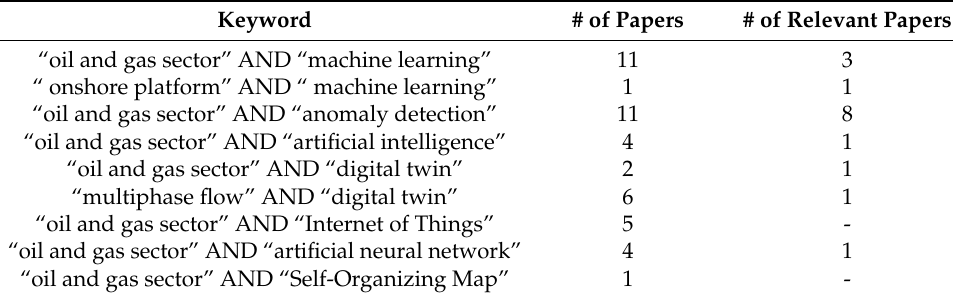
Figure 1. Oil and gas documents by year. Table 1. Summary of the selected literary contributions.